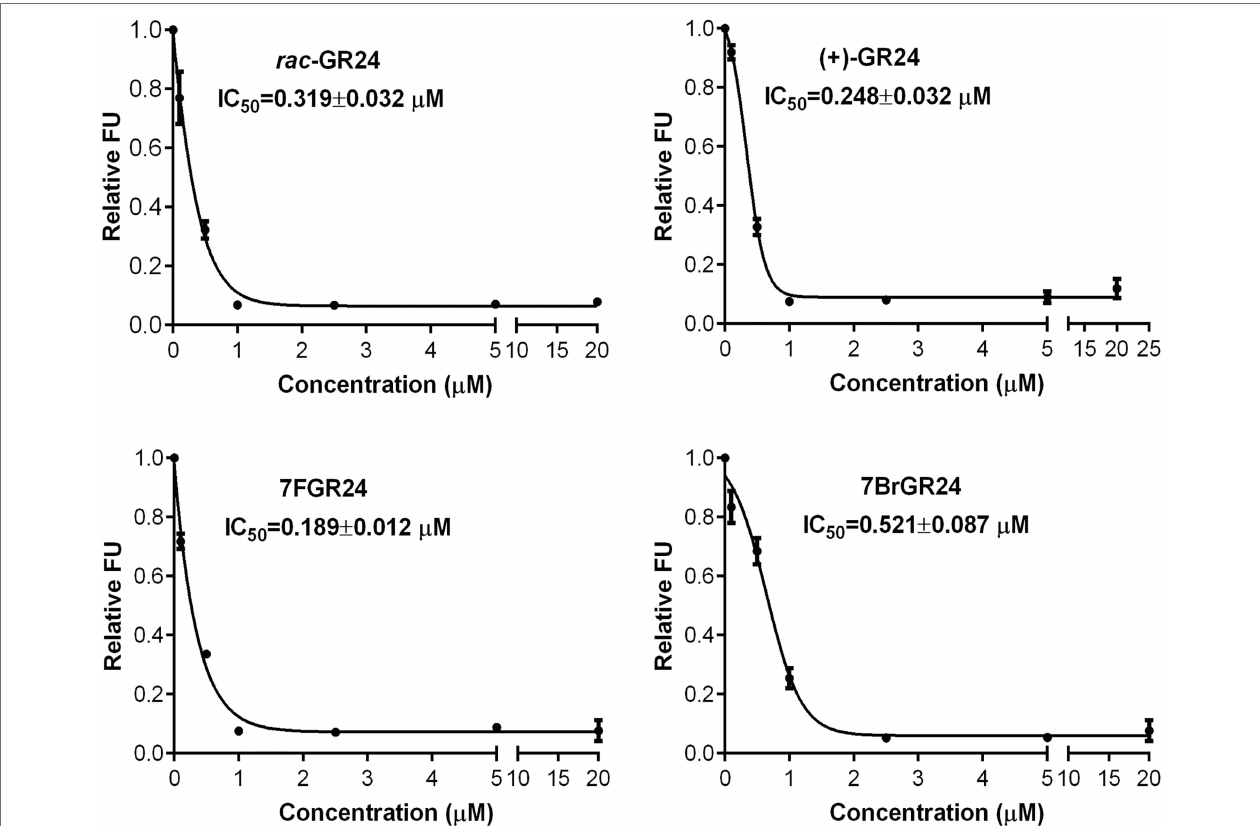
FIGURE 4 | Relative fluorescence unit (FU) values were recorded for rac -GR24, (+)-GR24, and the halogenated (+)-GR24 analogs when tested at several concentrations in the yoshimulactone green (YLG) assay. IC 50 values for these strigolactone (SL) analogs were calculated. Values represent means ± SD ( n =